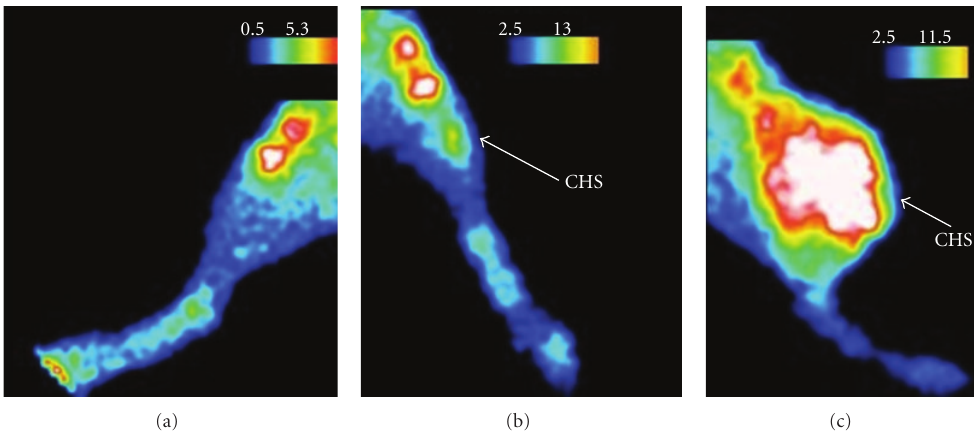
Figure 8: 99m Tc-NTP 15-5 longitudinal in vivo examination of a representative SRC-bearing rat; (a) in vivo scintigraphic image of the contralateral paw at day 4; (b) in vivo scintigraphic image of the tumour-bearing paw at day 4; (c) in vivo scintigraphic image of the tumour bearing paw of the same animal at day 35. A clear accumulation of radioactivity within tumoural tissue was observed as early as day 4 after implant (Image b, arrow); abbreviations: CHS = chondrosarcoma.